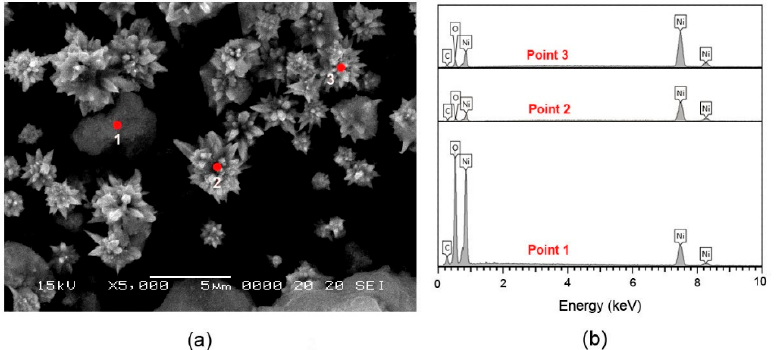
Figure 3. SEM image ( a ) and EDS spectra in different regions ( b ) of the product formed in 200 mL of 15 M NaOH solution containing 1.5 mL EDA. Reaction duration is 2 h.